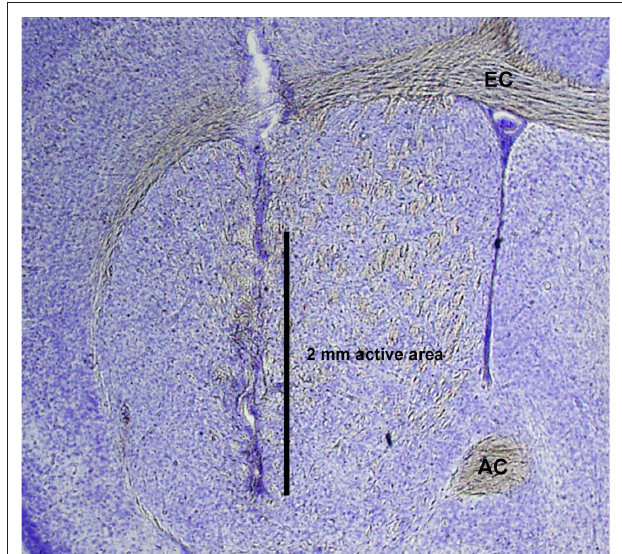
Figure 1 | Photomicrograph of Nissl-stained histological section demonstrating representative microdialysis probe placement with a 2-mm active area in mouse striatum. AC, anterior commissure; EC, external capsule.